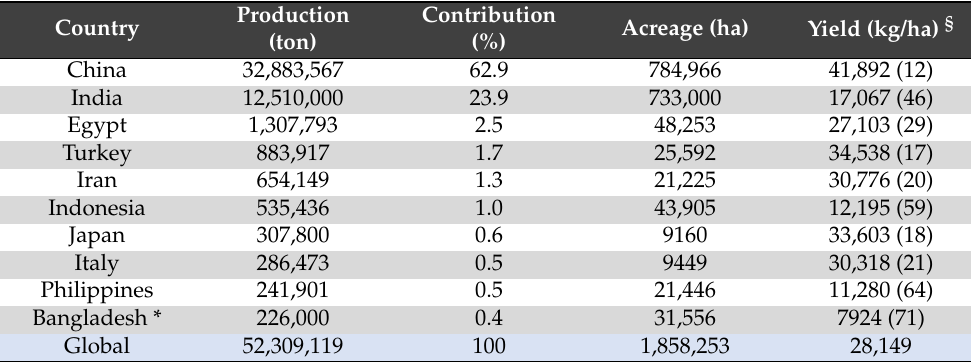
Table 1. Global status of brinjal production in